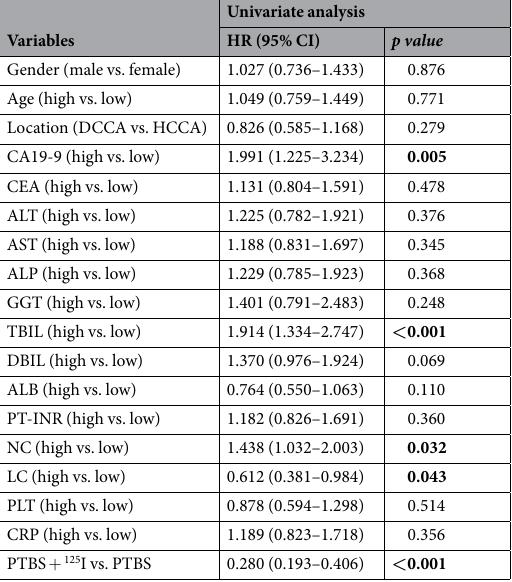
Table 2. Univariate analysis of factors associated with OS of EHC patients. HCCA hilar cholangiocarcinoma, DCCA distal cholangiocarcinoma, CA19-9 carbohydrate antigen 19-9, CEA carcino-embryonic antigen, ALT alanine aminotransferase, AST aspartate aminotransferase, ALP alkaline phosphatase, GGT gamma- glutamyl transpeptidase, TBIL total bilirubin, DBIL direct bilirubin, ALB albumin, PT-INR prothrombin time-